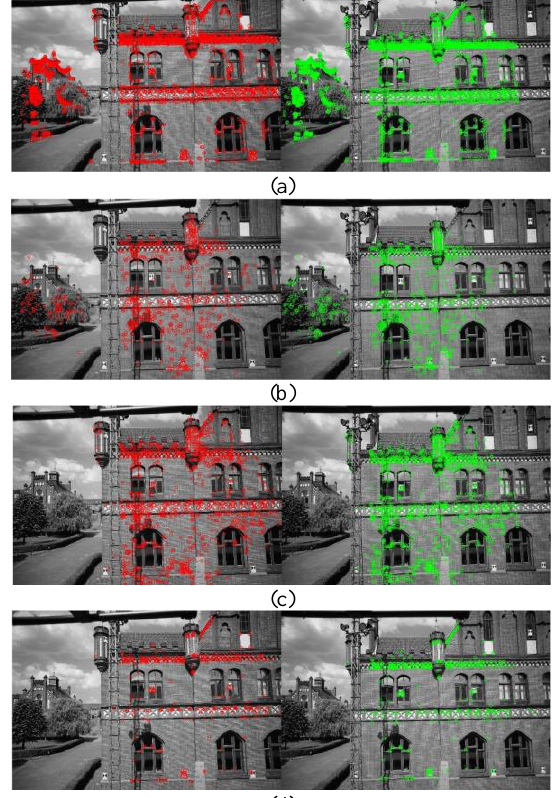
Figure 8. Feature correspondence for the second image